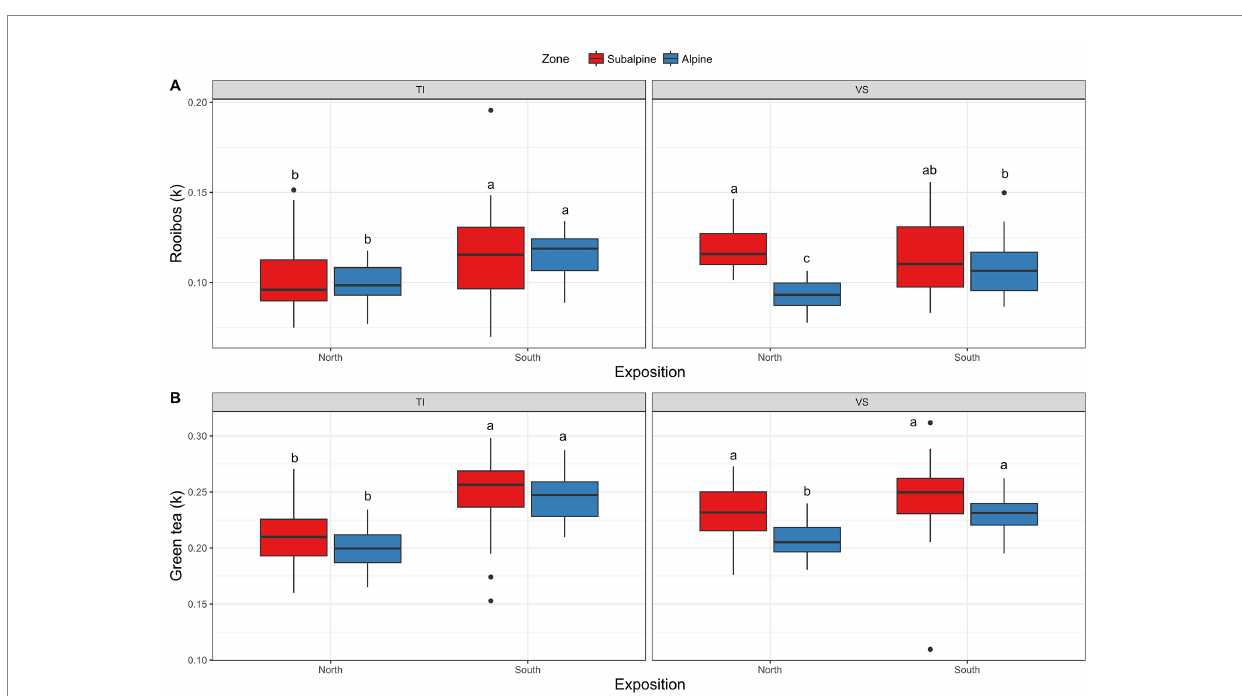
FIGURE 5 Degradation of teabags. Shown is (A) Boxplots representing rooibos degradation (k values), and (B) green tea degradation (k values) at each site separated by exposition (North versus South facing slopes), and regions (Ticino = TI, or Valais = VS ). Red color (warm) represents the sub-alpine zone (~1,400 m above sea level), and blue color (cold) represents the alpine zone (~2000 m above sea level). N = 3 plots per site. The k values represent the percent of tea weight loss per day.